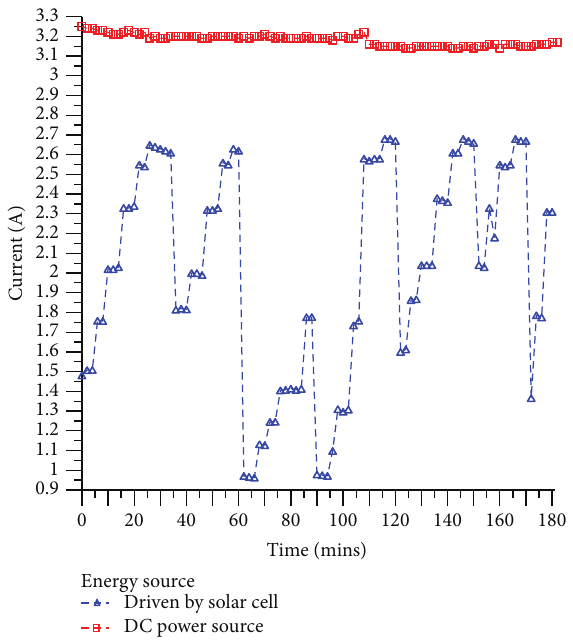
Figure 5: The electric currents of thermoelectric system driven by DC source and solar cells.